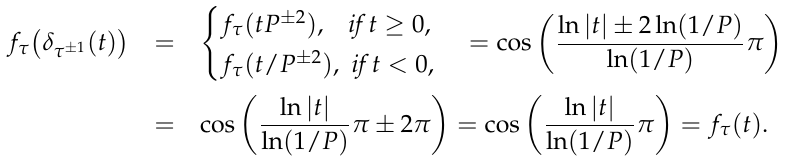
|√ |√ (cid:0) ln (cid:1) + (cid:0) ln (cid:1) 2 t | 3 t | π π cos with P 1 = 2, P 2 = 3 ln ( 1/ P 1 ) ln ( 1/ P 2 )